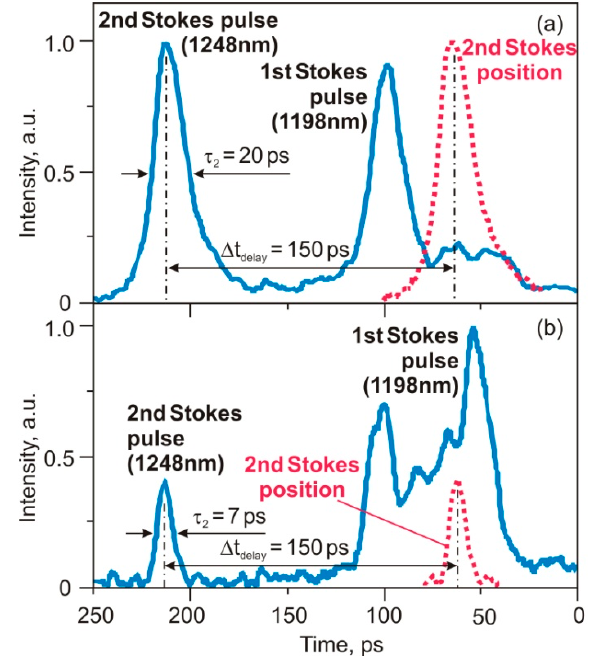
Figure 5. Individual SRS pulse shapes and relative positions measured by a streak camera at ( a ) zero detuning and ( b ) +8 mm detuning of the Raman laser cavity length.